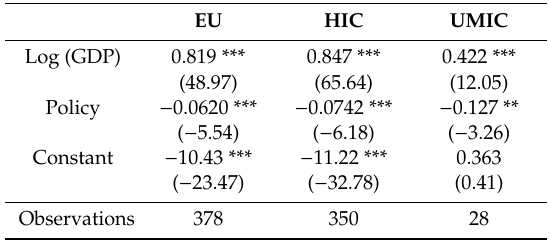
Table 4. E ff ect of policy and GDP on CO 2